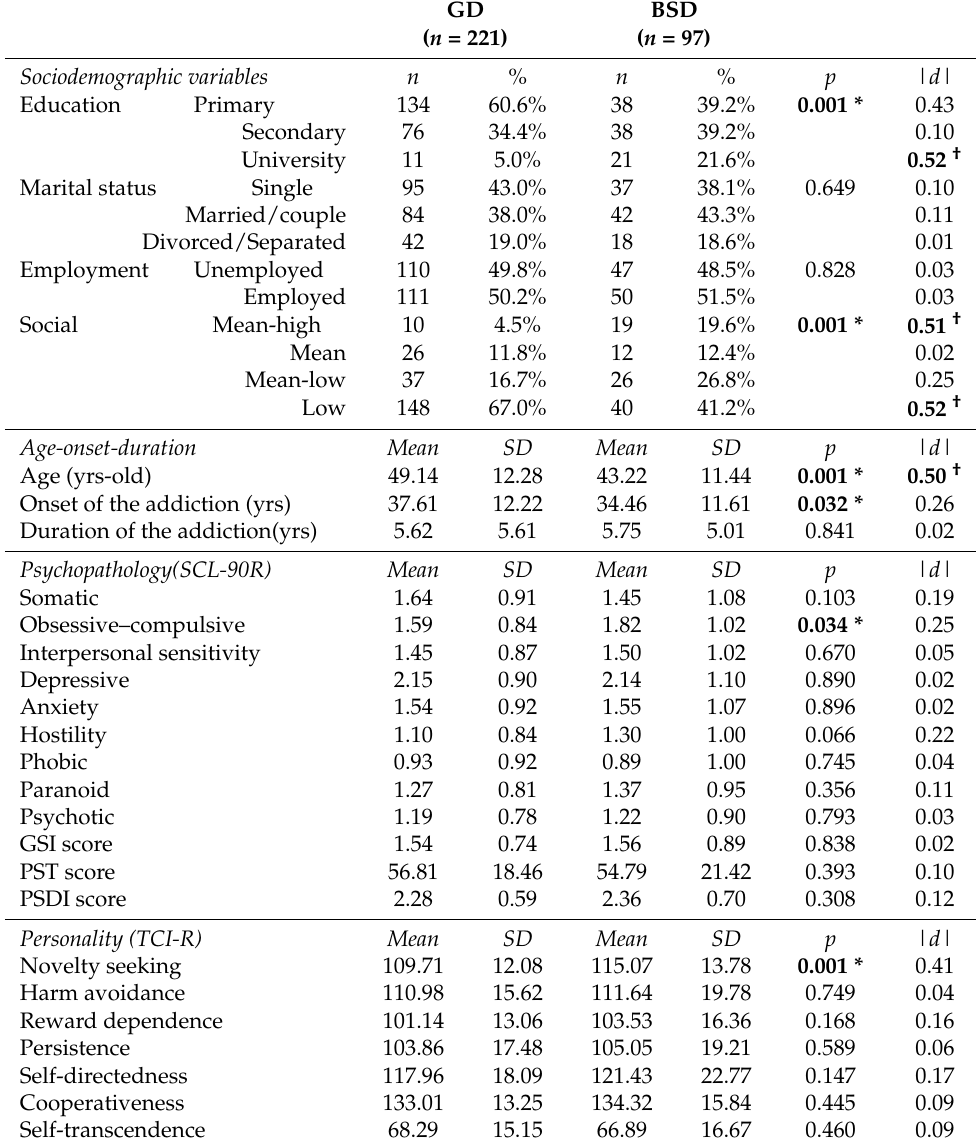
Table 1. Descriptive for the variables of the